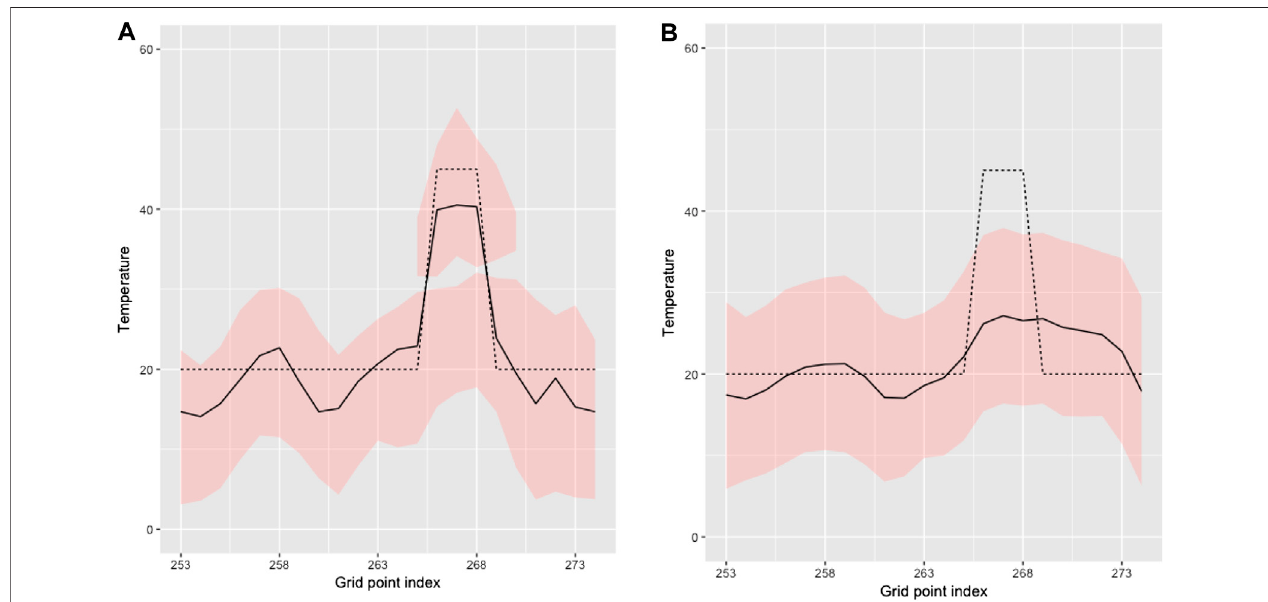
FIGURE 11 | MMAP predictions (solid black line) with HDI 0.8 (red) intervals in cross section A-A ′ of initial state at current time T (cid:2) 50 with selection Kalman model (left) and with traditional Kalman model (right) . True cross section (dotted line).